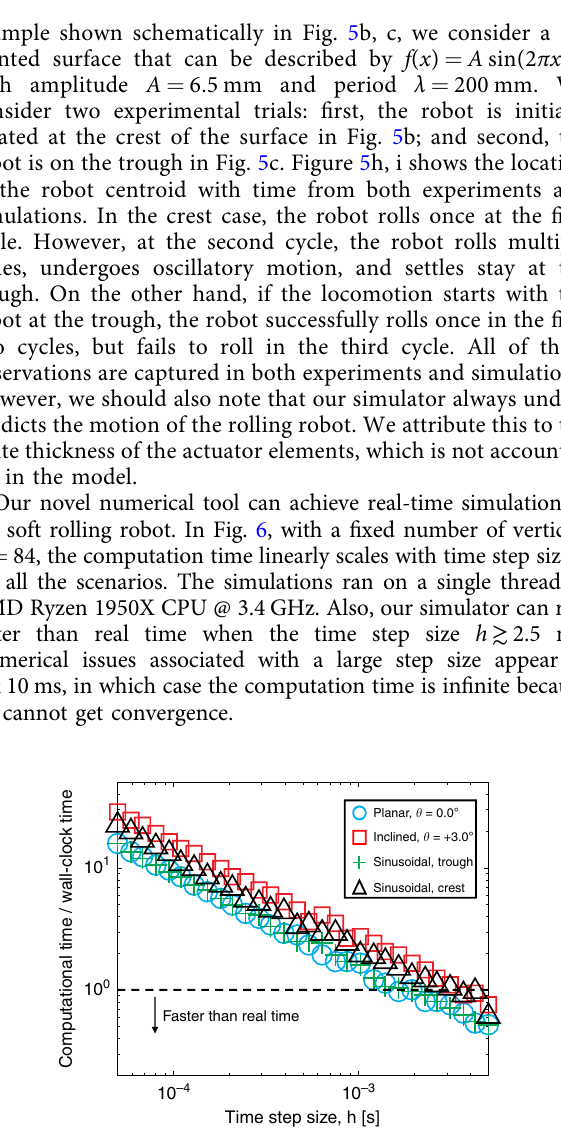
Fig. 6 Computational time. The ratio between computational time and wall-clock time as a function of time step size h in different scenarios with N = 84.